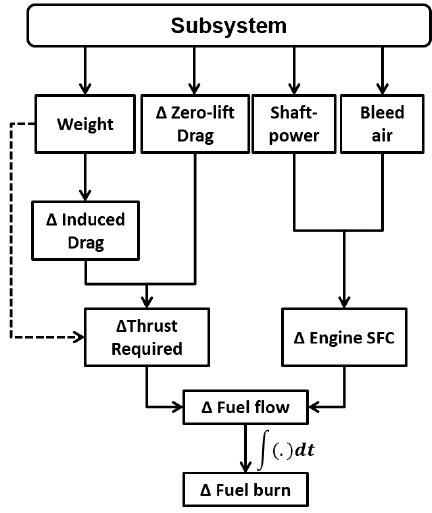
Figure 1. Tracing impact of subsystem architecture changes on fuel burn